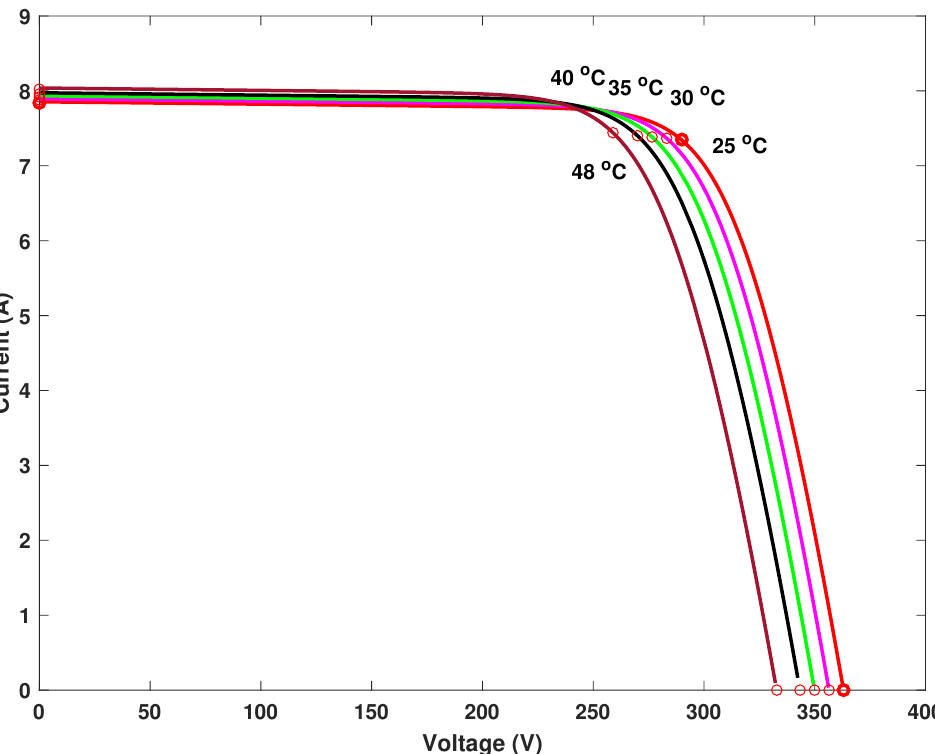
Figure 4. Characteristic curve of PV voltage and current under changing